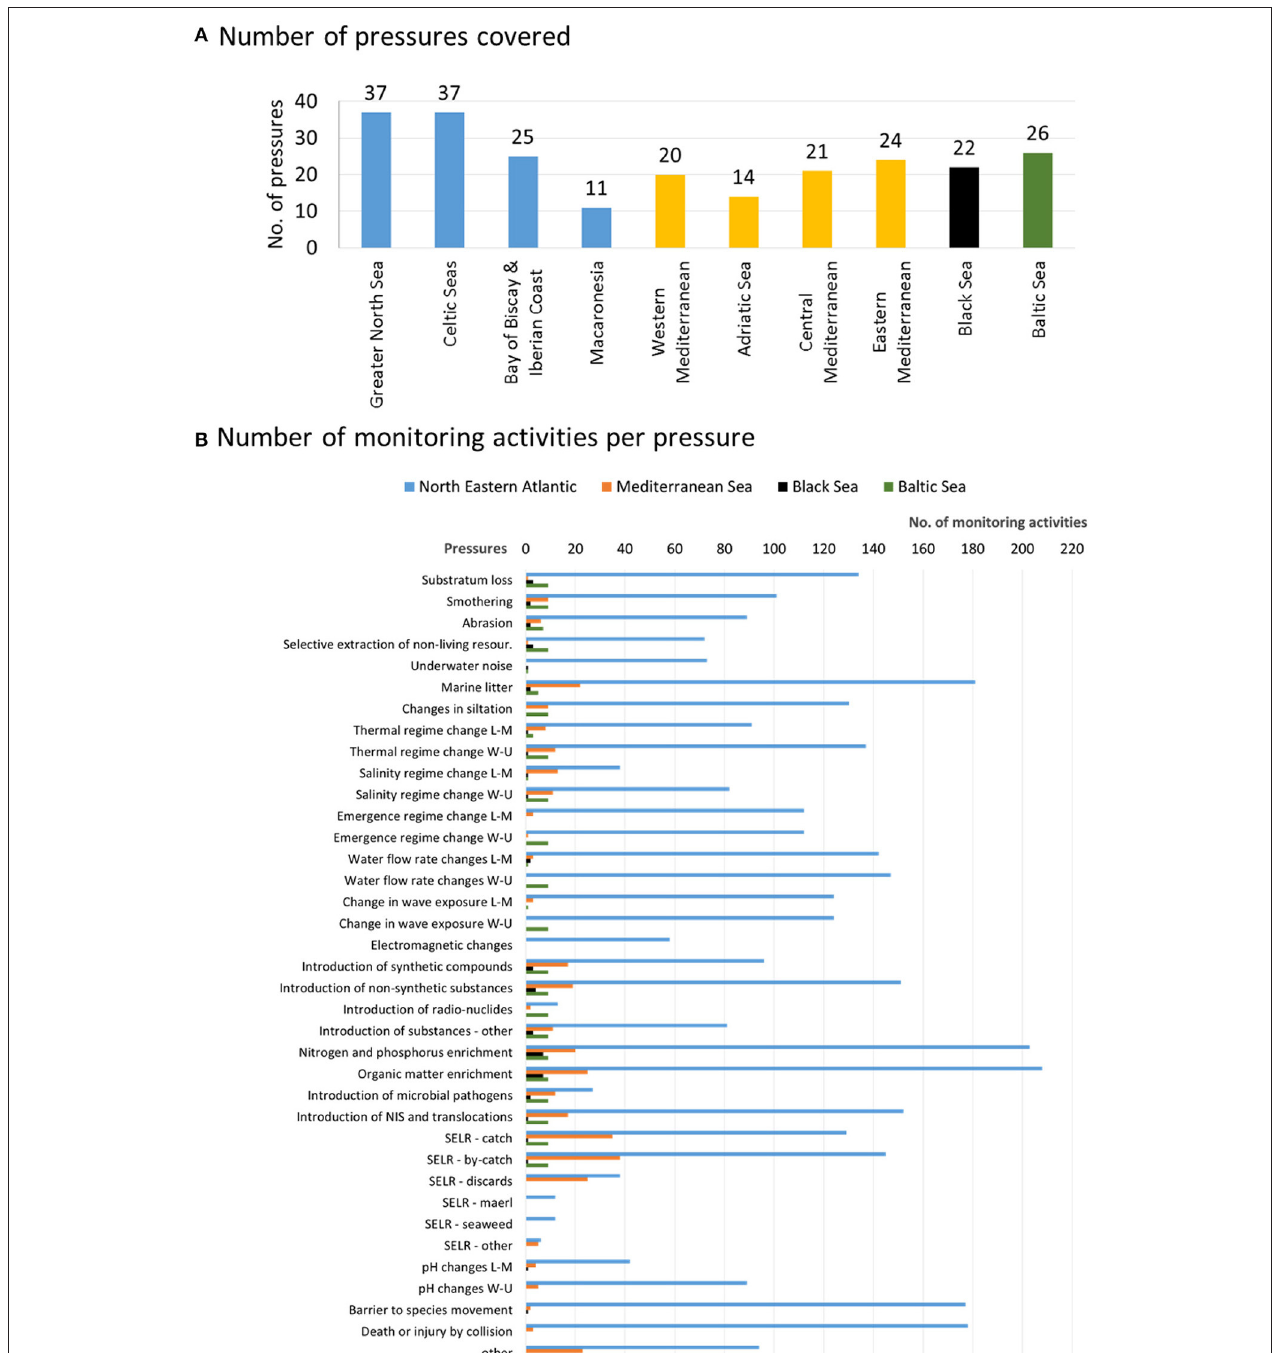
FIGURE 6 | (A) Number of pressures covered and (B) . Number of monitoring activities per pressure in the North Eastern Atlantic (sub-regions: Greater North Sea, Celtic Seas, Bay of Biscay, and Iberian Coast, Macaronesia), Mediterranean Sea (sub-regions: Western Mediterranean, Adriatic Sea, Central Mediterranean including the Ionian Sea, Eastern Mediterranean), Black Sea, and Baltic Sea. L-M, Local and manageable; W-U, Widespread and unmanageable; SELR, Selective extraction of living